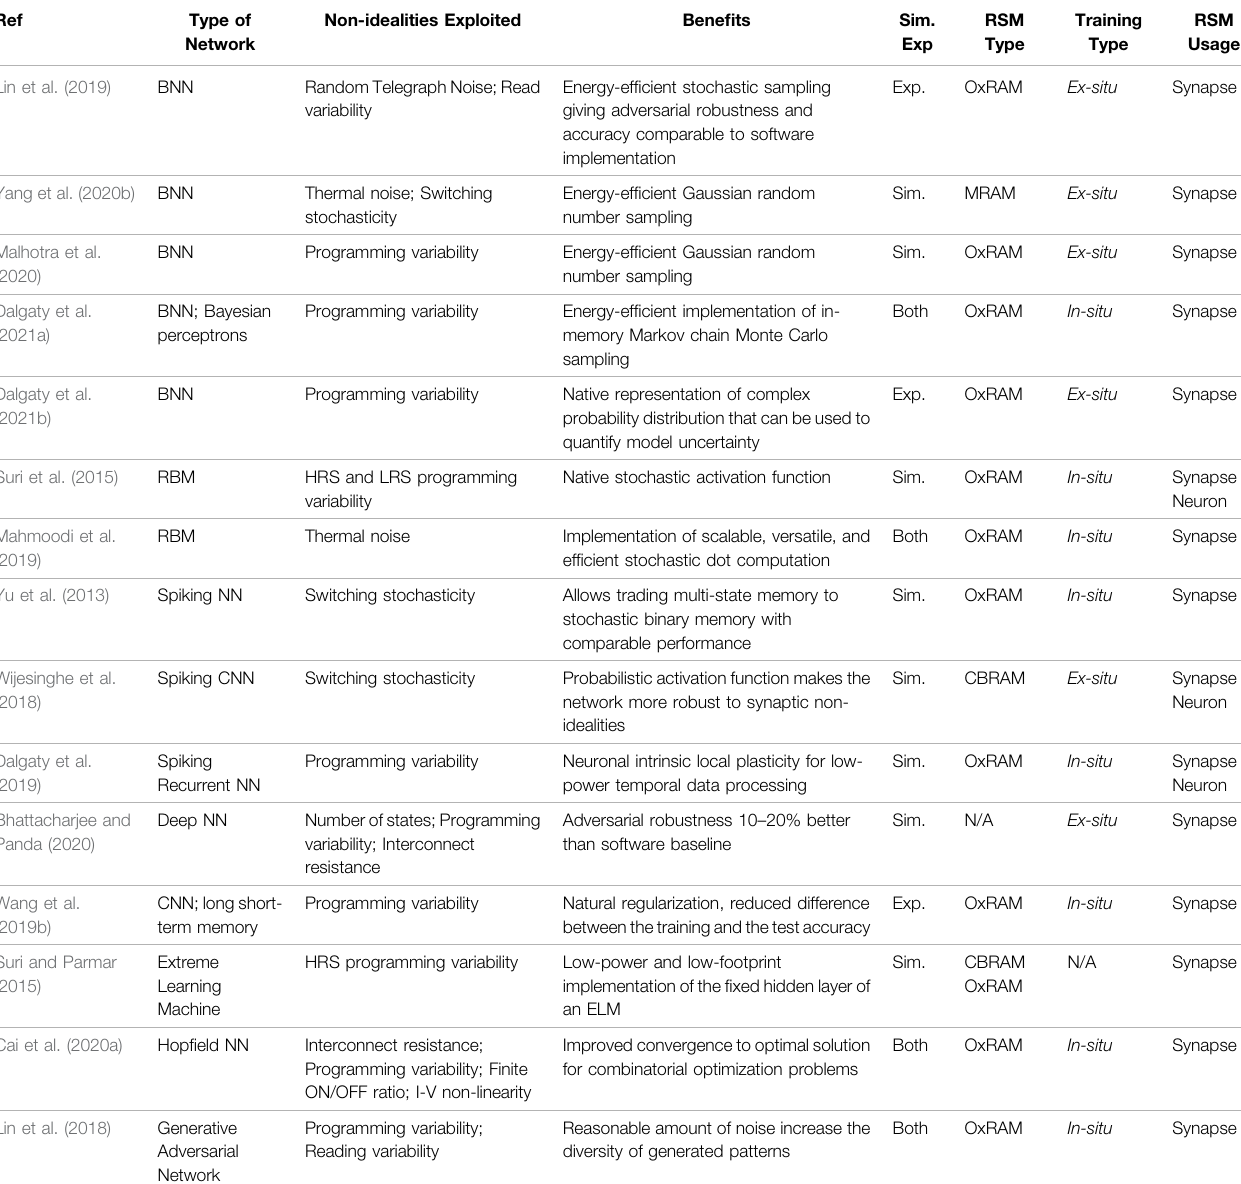
TABLE 1 | Summary of reported RSM-based NNs that exploit non-idealities in an explicit way to improve the accuracy or ef fi ciency of the model. Sim. and Exp. stand for Simulation and Experimental , Conductive-Bridging Random-Access Memory (CBRAM), Oxide-based Random-Access Memory (OxRAM), Magnetoresistive Random- Access Memory